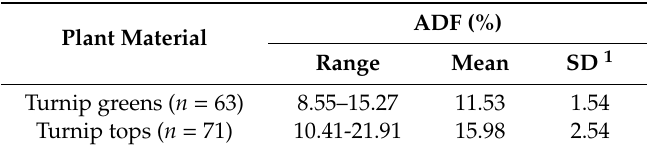
Table 1. Fibre content in samples of turnip greens and turnip tops of Brassica rapa , analysed in the laboratory.